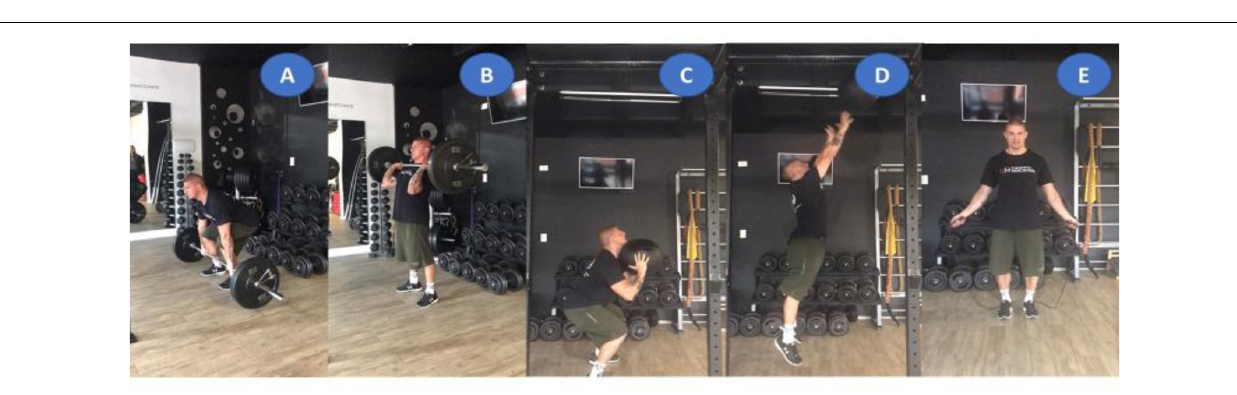
FIGURE 3 | Illustration of the extreme conditioning program training session composed of clean (A,B) , wall ball (C,D) , and double-unders (E) exercises. Informed consent was informed, written and obtained from this volunteer for publication of their